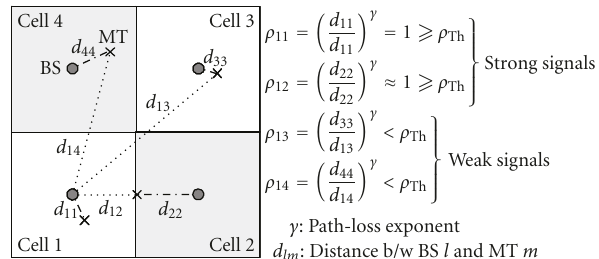
Figure 1: An example setup showing a rectangular grid of 4 cells, with power control assumed with respect to associated